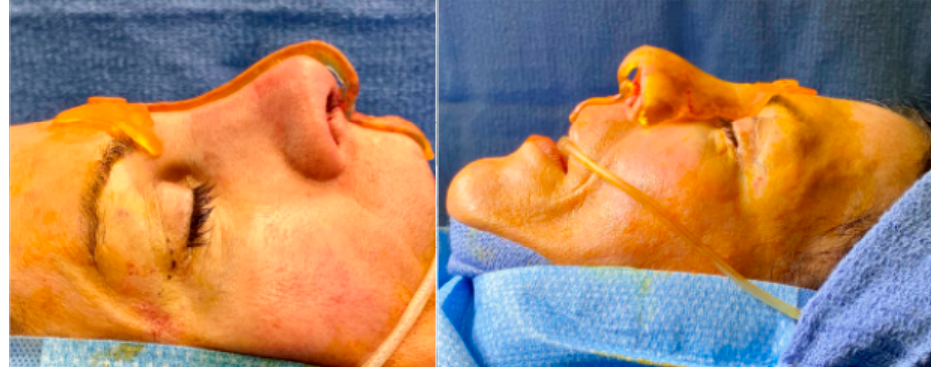
Figure 2. 3D printed guide for rhinoplasty [104].